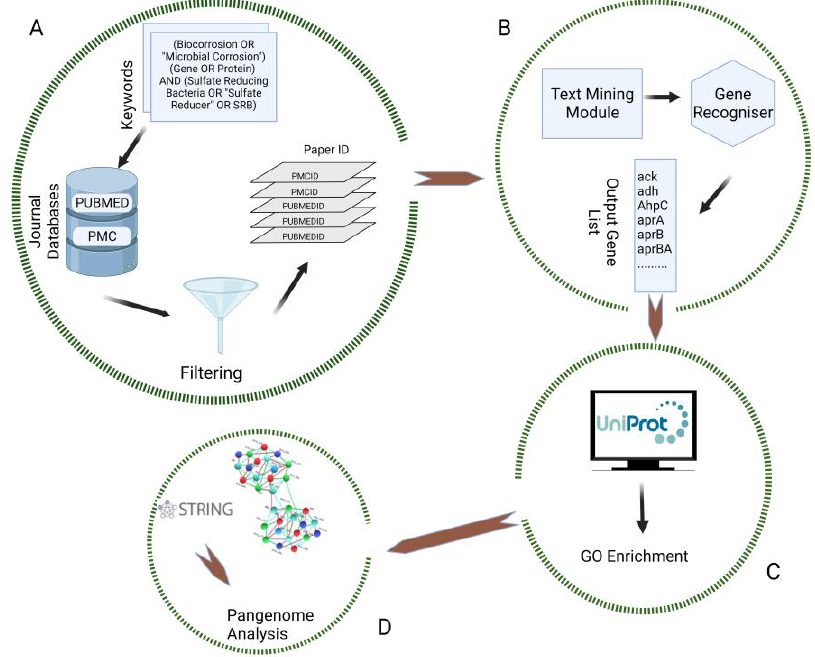
Figure 1. Text-mining workflow utilized to obtain relevant gene lists. ( A ) Query formulation to extract relevant research articles; ( B ) Gene mining from the literature; ( C ) Enrichment analysis of the gene sets; ( D ) Pangenome and PPI network analysis.